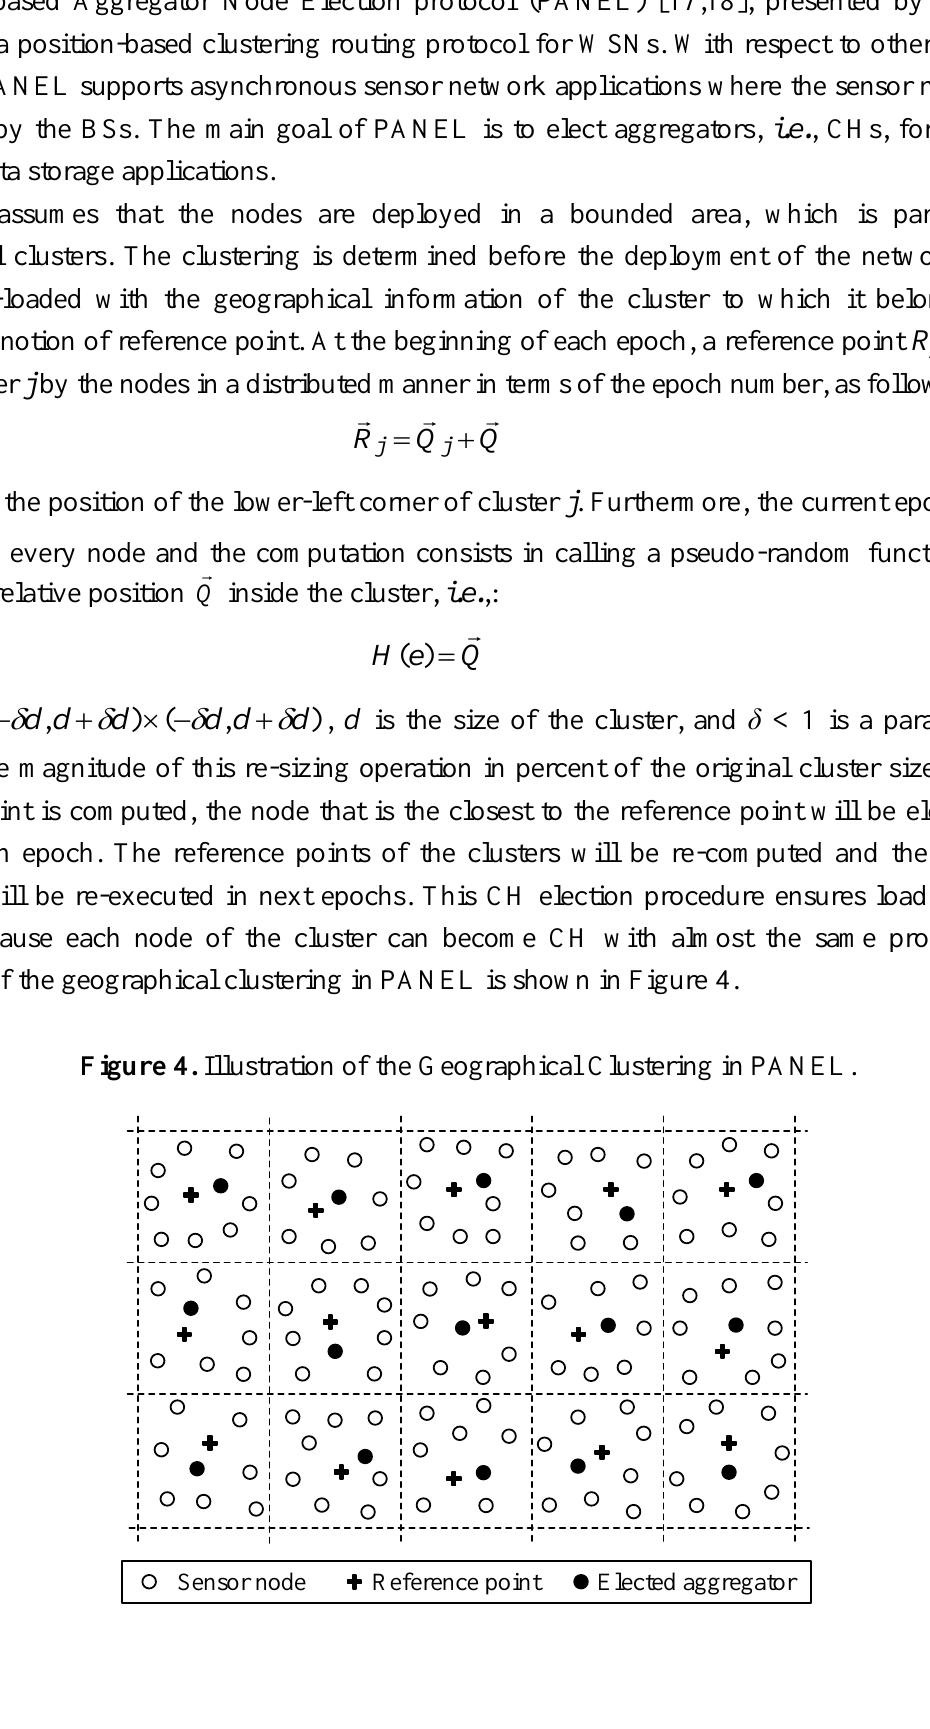
Reference point Elected aggregatorSensor